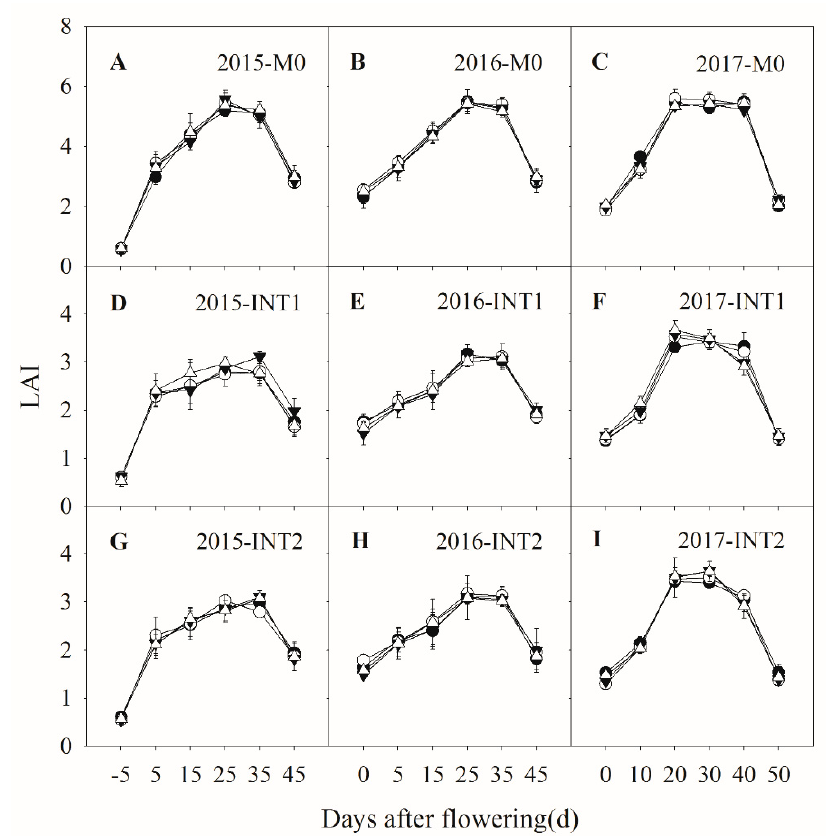
Figure 3. Dynamic changes of leaf area index (LAI) for the di ff erent soybean cultivars ( ● : HD19; ○ : HD20; ▼ : ZH39, and △ : QH34) under different planting patterns ( A , B and C for M0; D,E and F for INT1; G , H and I for INT2) at the days after anthesis during 2015–2017. Each value is the mean ( n =